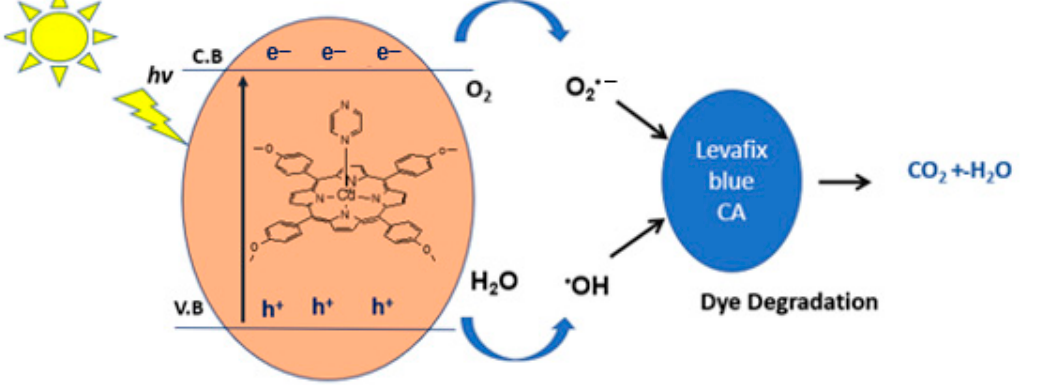
Figure 13. The postulated mechanism for the degradation of Levafix Blue CA reactive dye in water.